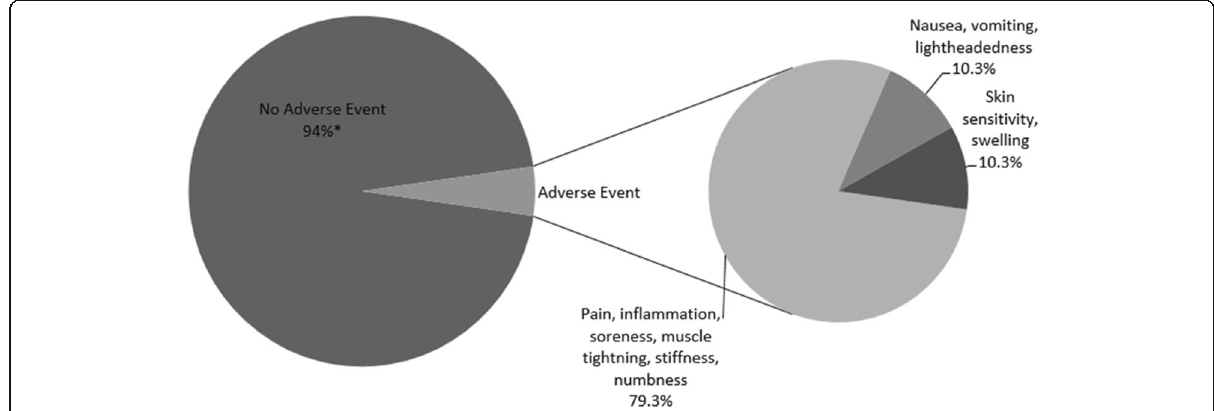
Fig. 2 Adverse events reported. Adverse events (AE) related to the procedure were reported by 6.2% of patients. Of those 79.3% were categorized as pain related, 10.3% were dural puncture-related and 10.3% were skin reactions. *The percentage of patients without